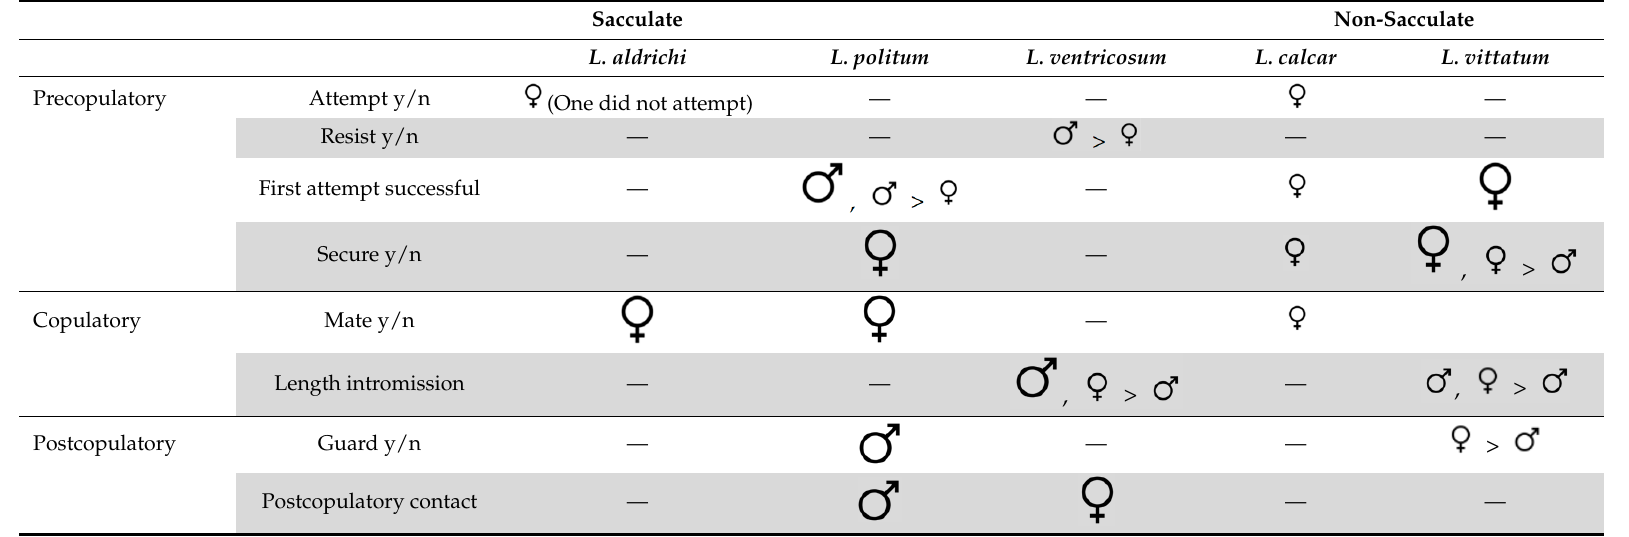
Table 4. How the size of males and females predict the success and timing of each stage of mating in the five species of leiobunine harvestmen studied. The size of the male and female symbol indicate whether larger or smaller males/females were more likely to either be successful at a given stage, or more likely to have a longer duration of a given stage. When the relative size of males versus females predicted outcome, the ‘<’ and ‘>’ symbols indicate the relationship dictating the most successful or longest duration of a stage. The “—” indicates that neither male nor female body size predicted outcome. Sacculate species are on the left, and non-sacculate species are on the right with the continuum of antagonism going from low antagonism to high antagonism from left to right.